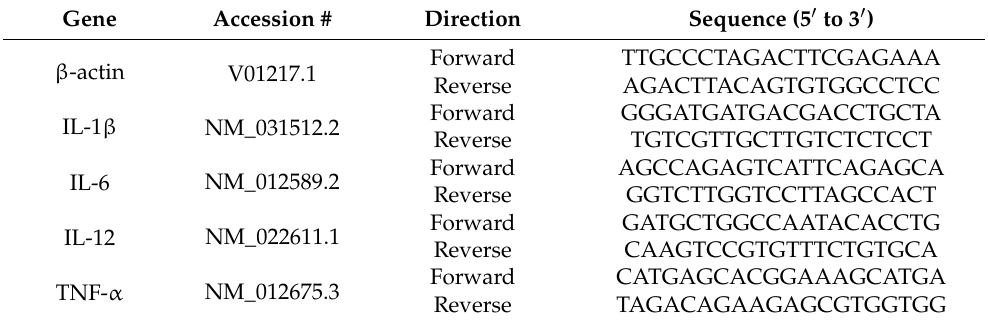
Table 1. The specific primers sequence used for PCR quantification of mRNA